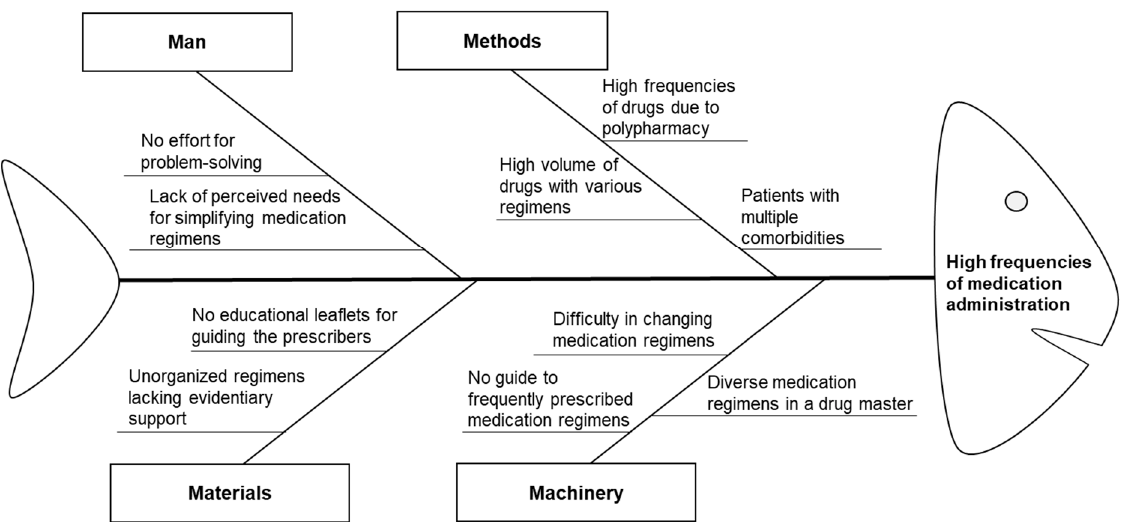
Figure 2. Fishbone diagram outlining barriers to reducing unnecessary dosing frequencies during medication administration.